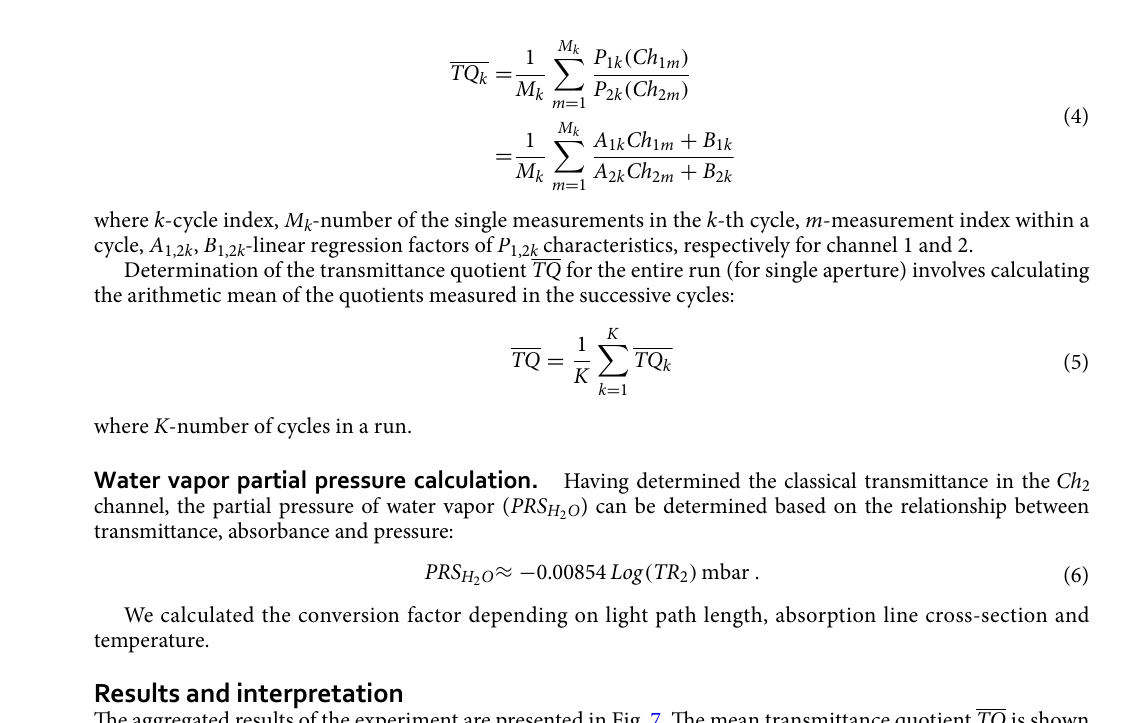
Figure 6. Example of the Ch 1 , Ch 2 and transmittance quotient ( TQ ) measurements within a single